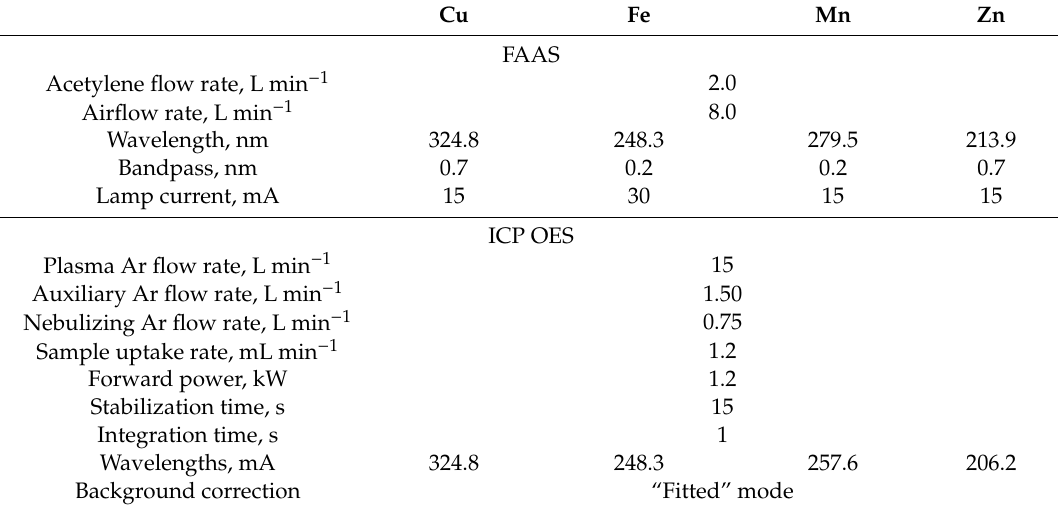
Table 3. Operating parameters used for flame atomic absorption spectrometry (FAAS) and inductively coupled plasma optical emission spectrometry (ICP OES). Cu Fe Mn Zn